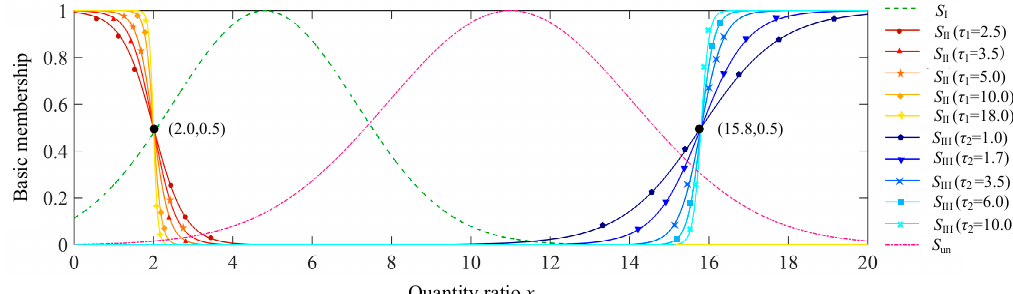
Figure 4. Basic membership functions with the change of parameters τ 1 and τ 2. 297